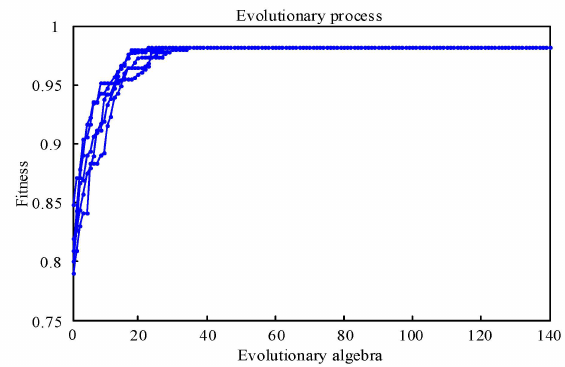
Figure 9. Convergence procedure of the MPGA under fault scenario